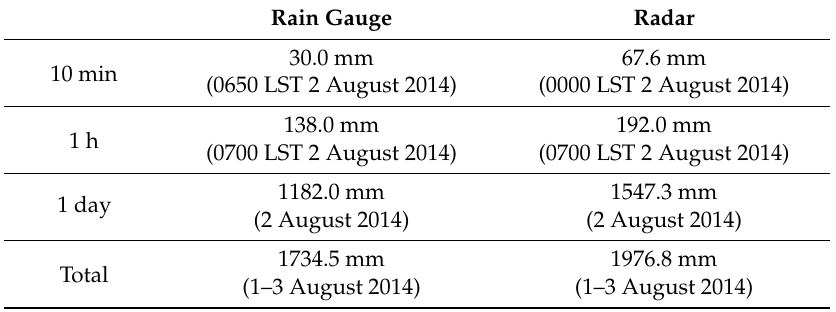
Table 2. Comparison of maximum rainfall depths recorded by rain gauge and radar for several rainfall durations.